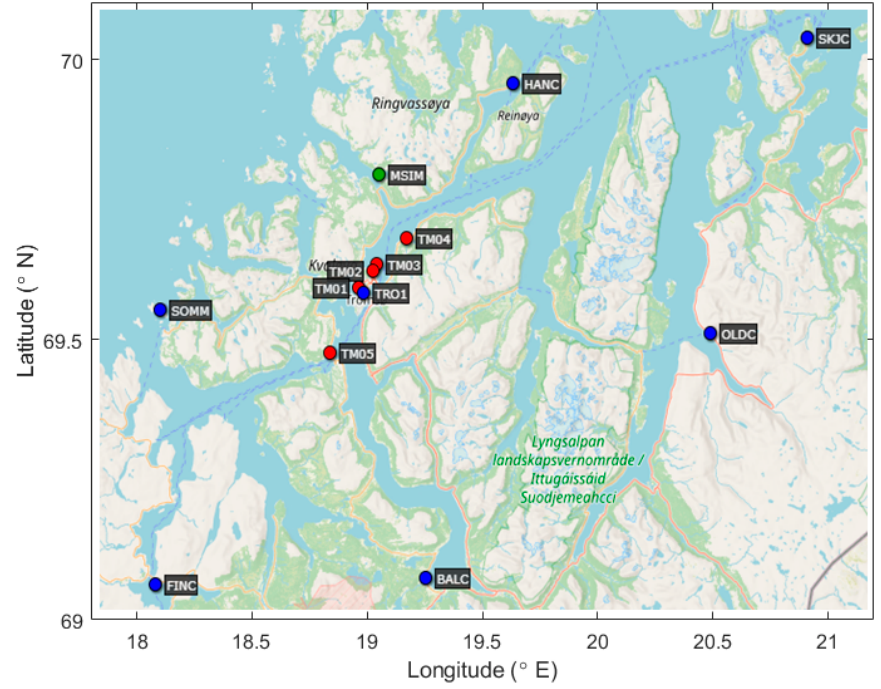
Figure 1. Map of the receiver locations (blue: CPOS reference receivers, green: CPOS monitoring receiver, red: test receivers).